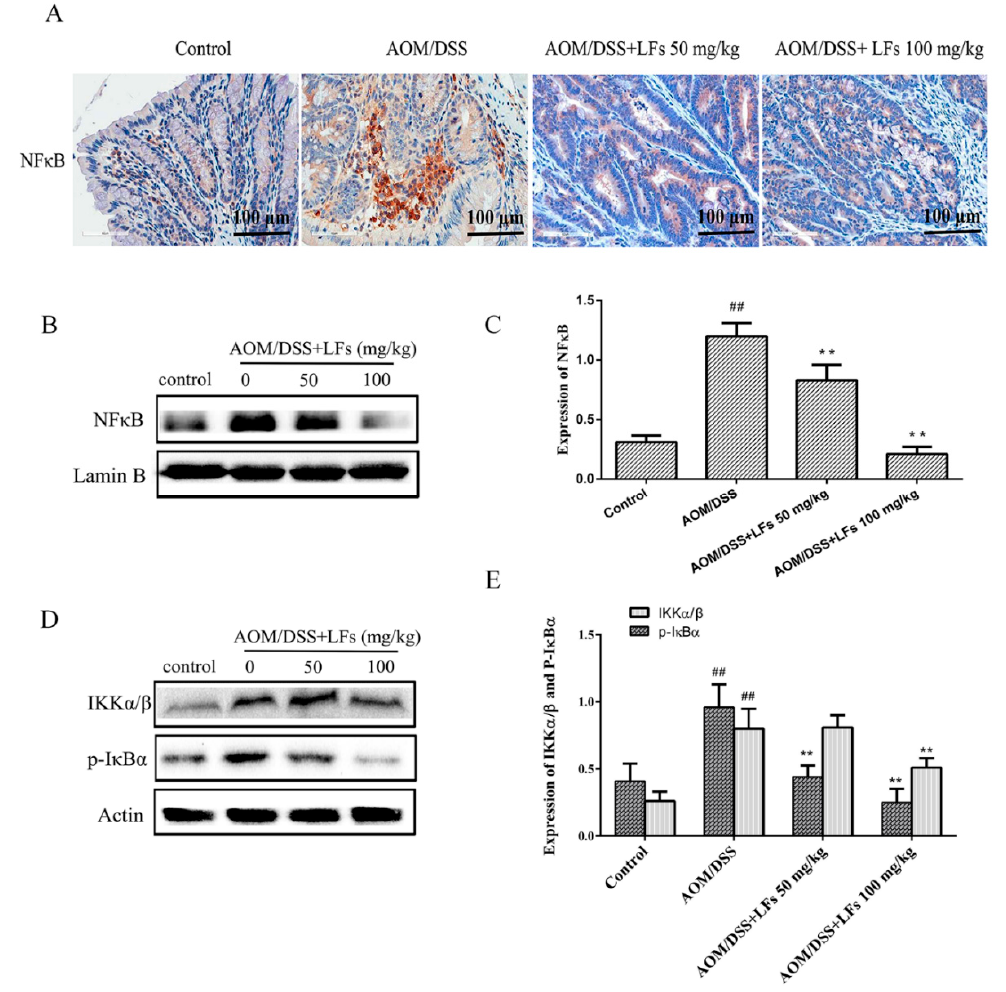
Figure 6. Effects of LFs on NF κ B activation. ( A ) Immunohistochemical staining of NF κ B in colonic tissues; ( B , C ) Nuclear translocation of NF κ B assessed by Western blot and semi-quantitative analysis of these proteins. Nuclear proteins were used to conduct Western blot analysis. Data are presented as mean ± SD. ** p < 0.01 vs. model, ## p < 0.01 vs. vehicle control; ( D , E ) Western blot of IKK α / β and p-I κ B α expression in colonic tissues and semi-quantitative analysis of these proteins. Data are presented as mean ± SD. ** p < 0.01 vs. model, ## p < 0.01 vs. vehicle control.